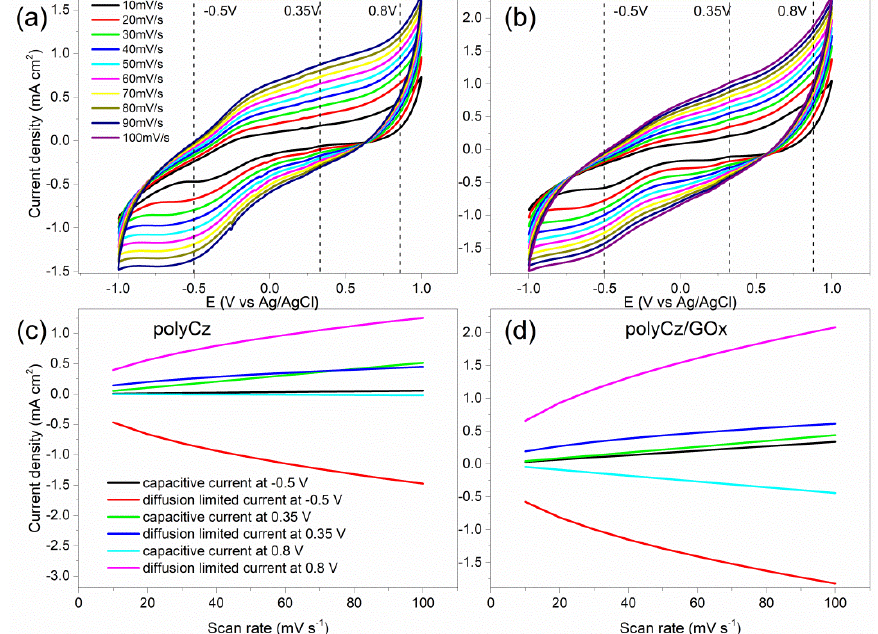
Figure 4. Cyclic voltammograms of ( a ) the polyCz and ( b ) polyCz/GOx electrodes in 0.1 M PBS (pH 7.4) at different sweep rates; calculated current densities of faradaic and pseudocapacitive processes at −0.5, 0.35, 0.8 V vs Ag/AgCl on ( c ) the polyCz and ( d ) polyCz/GOx electrodes.